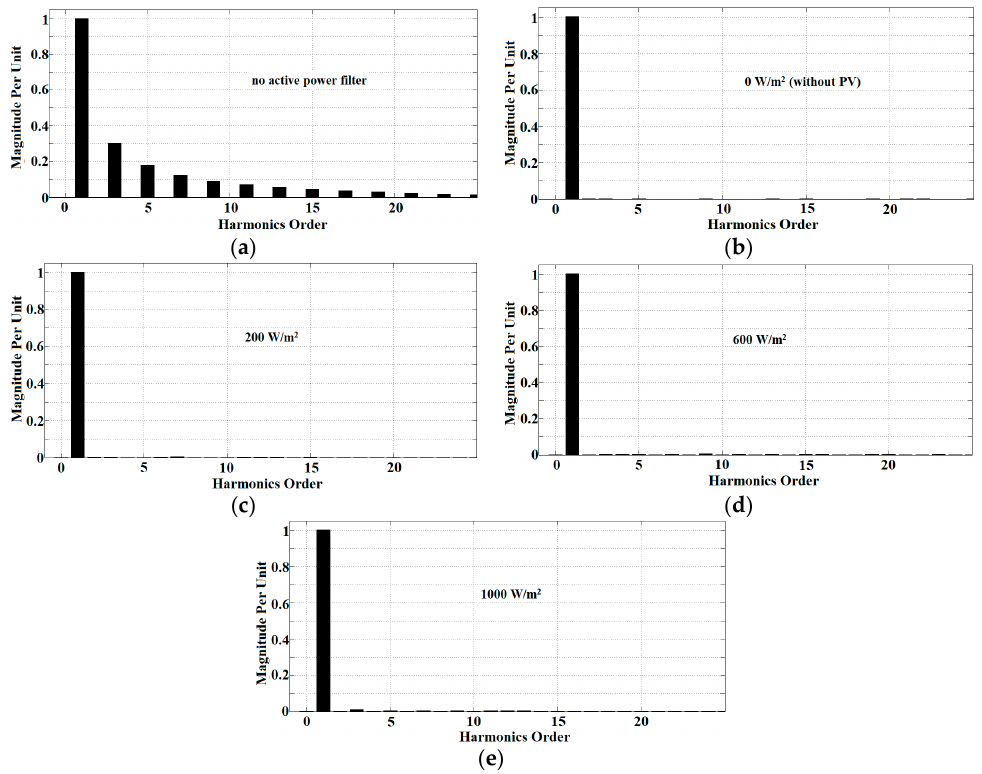
Figure 8. Simulation results of harmonic spectra for inductive load using Simpler ADALINE algorithm with ( a ) no active power filter and at ( b ) 0 W/m 2 (without PV), ( c ) 200 W/m 2 , ( d ) 600 W/m 2 , and ( e ) 1000 W/m 2 .